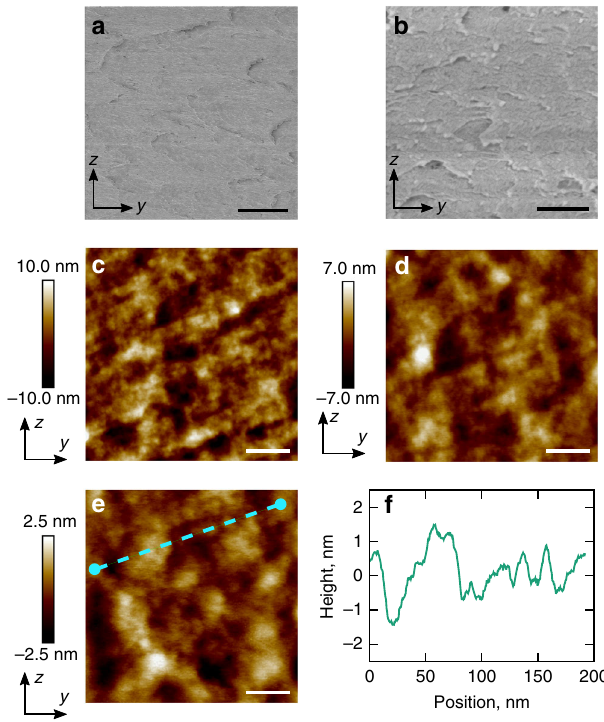
Fig. 2 Micro- and nano-scopic structure of the LCE. a , b Cryo-SEM micrographs (scale bars, 2.5 µ m and 250 nm, respectively) and c – e AFM height maps (scale bars, 200, 100 and 40 nm, respectively) show the structures present from molecular to microscopic length scales. Vertical colour bars accompanying AFM height maps represent height in nm. Axes used in a – e correspond to the coordinate set from Fig. 1b. f Pro fi le of dashed line drawn across e